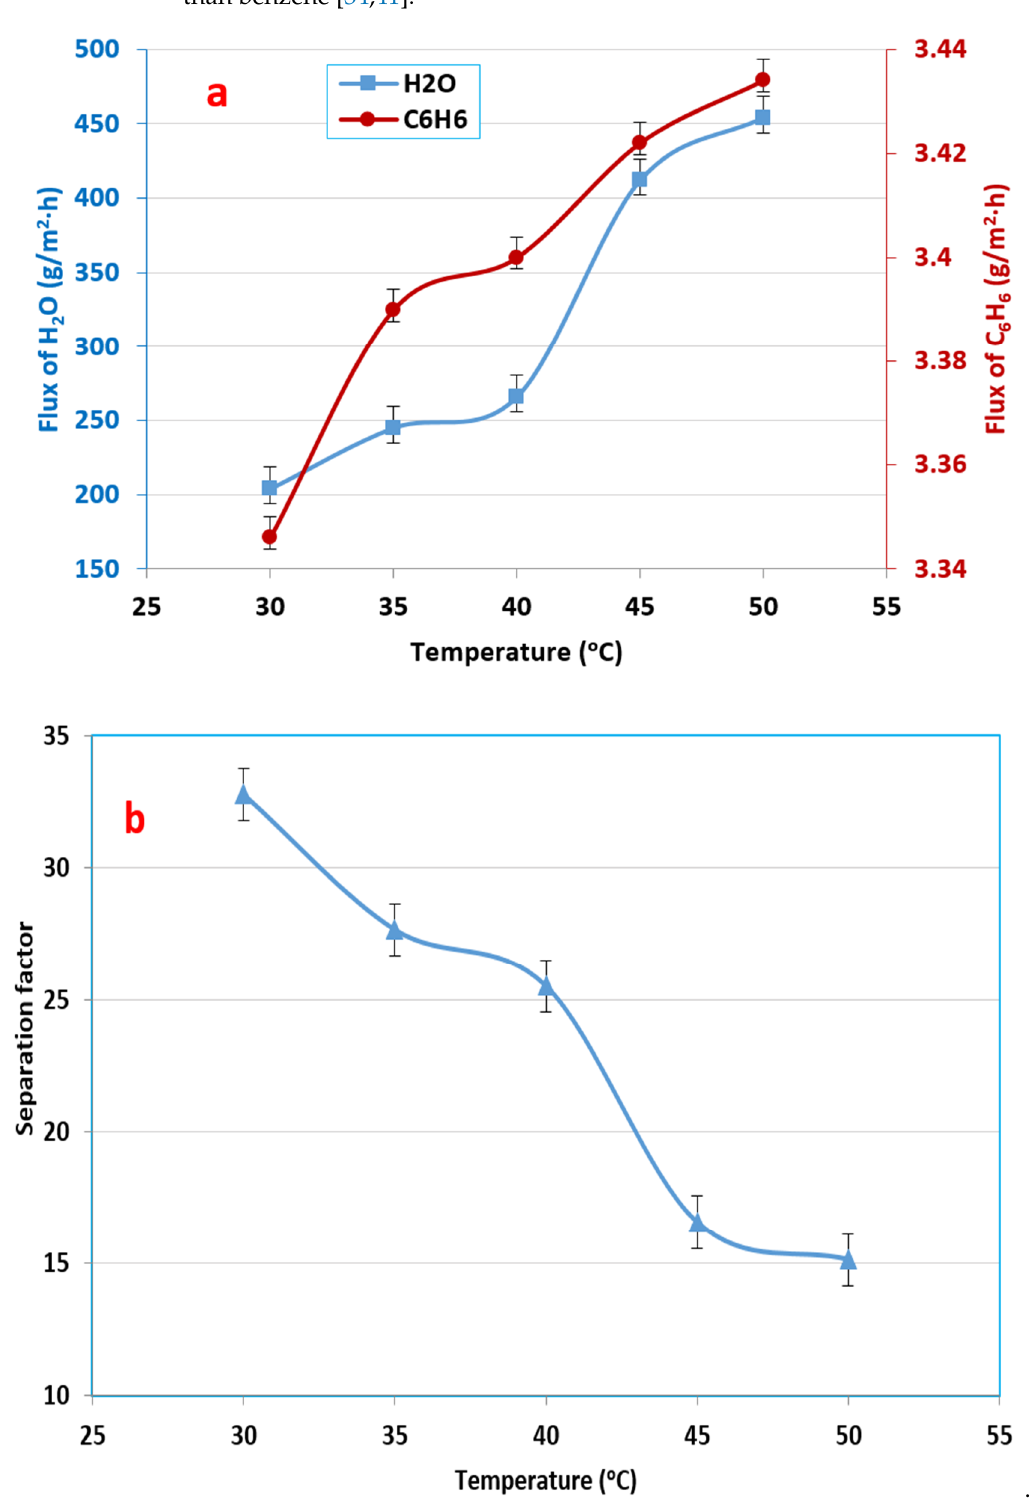
Figure 4. Effect of temperature on ( a ) the fluxes of benzene and water and ( b ) the separation factor, at an initial benzene feed concentration of 500 ppm and a 3 L/min feed flow rate.